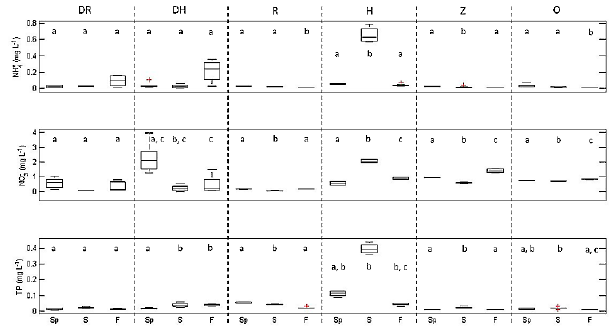
Fig. 6. Seasonal concentrations of DOC, TIC, and Chl a in the streams Rappbode (R), Hassel (H), Zillierbach (Z) and Ochsenbach (O) and the pre-dams Rappbode (DH) and Hassel (DH). Seasons are abbreviated as follows: Sp indicates spring, S indicates summer, and F indicates fall. The following numbers of samples were pooled in the box plots for DOC and TIC: in spring n = 6 for DR and DH, n = 7 for R, n = 8 for H and O, and n = 4 for Z; in summer n = 4 for DR, DH, R and H, and n = 8 for Z and O; in fall n = 4 for DR and DH, n = 8 for R, H, Z and O. For Chl a the following numbers were pooled: in spring n = 5 for DR and DH, n = 3 for R, H, Z and O; in summer and fall n = 4 for DR and DH, and n = 3 for R, H, Z and O. Significant differences between groups are indicated by letters a, b and c.